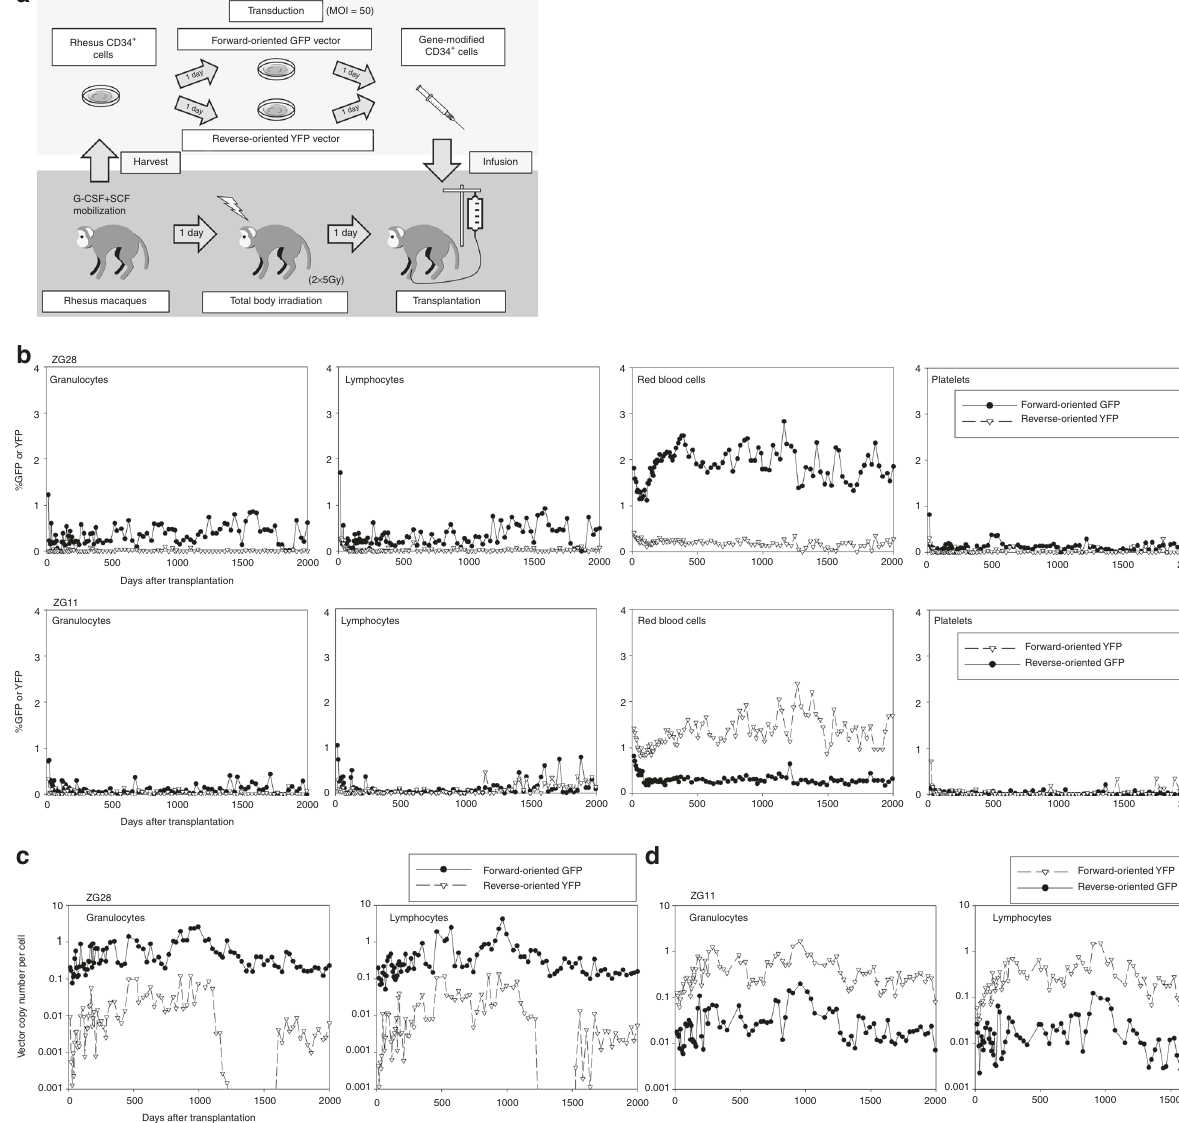
Fig. 2 Higher gene marking levels in long-term hematopoietic repopulating cells in rhesus macaques with the forward-oriented vector for globin expression. a To evaluate transduction ef fi ciency for long-term hematopoietic repopulating cells, we transduced rhesus CD34 + cells with the optimized reverse- oriented vector and forward-oriented vector including a GFP or YFP gene (instead of a globin gene) in a competitive repopulation assay following 10 Gy total body irradiation. b – d In two animals (ZG28 and ZG11), GFP and YFP gene-marking levels were evaluated by both GFP- or YFP-positive percentages ( b ) and VCNs ( c , d ) in peripheral blood cells with the forward-oriented vector up to 5 years, as compared with the reverse-oriented vector. G-CSF: granulocyte colony-stimulating